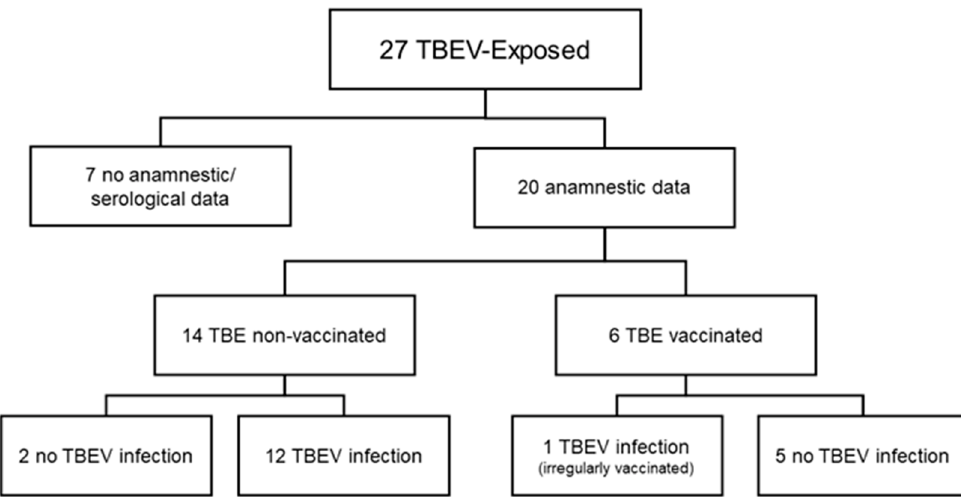
Figure 1. Number and proportion of exposed and infected persons.